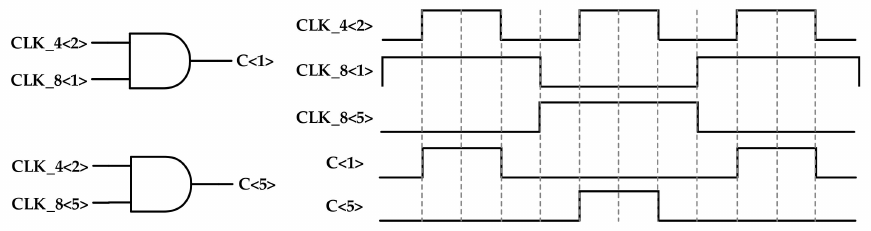
Figure 12. 25% duty cycle clock signal generation and voltage waveform.